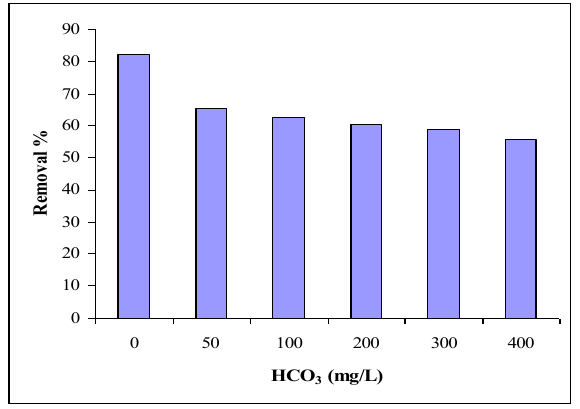
Figure 4 . Comparison of removal percentage for degradation of malathion in the presence of